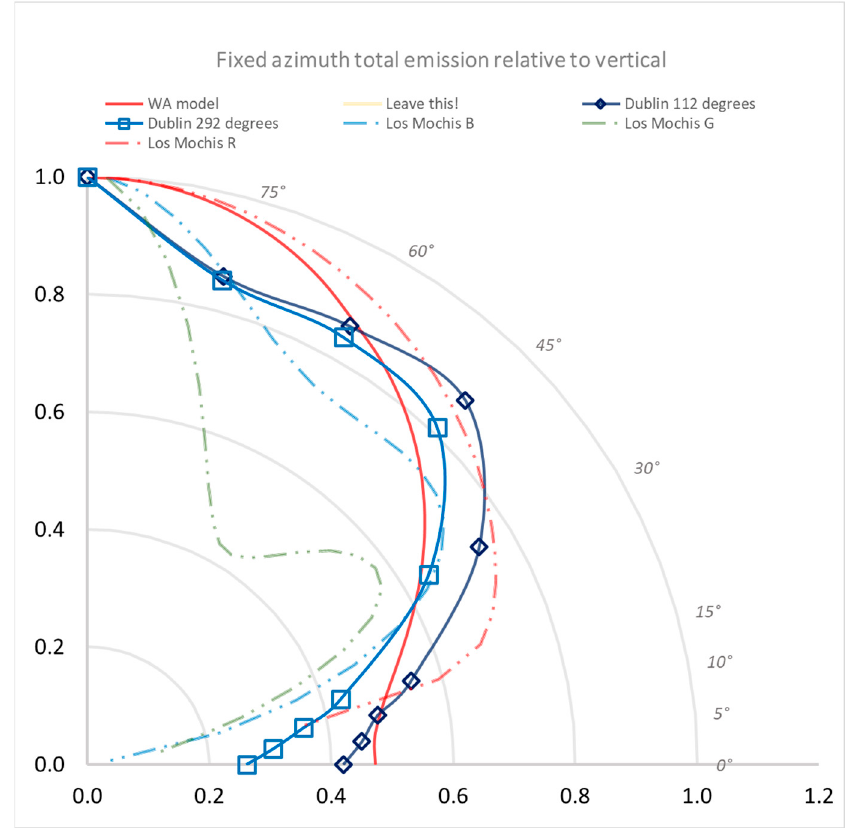
Figure 10. Comparison of normalised CEF for Dublin test area with the function used in the New World Atlas (solid red line) and the RGB inversion estimates for Los Mochis in Mexico (dash-double dot lines shown in the appropriate colour). Diamond and square points show the Dublin data for azimuths 112° and 292°, respectively.